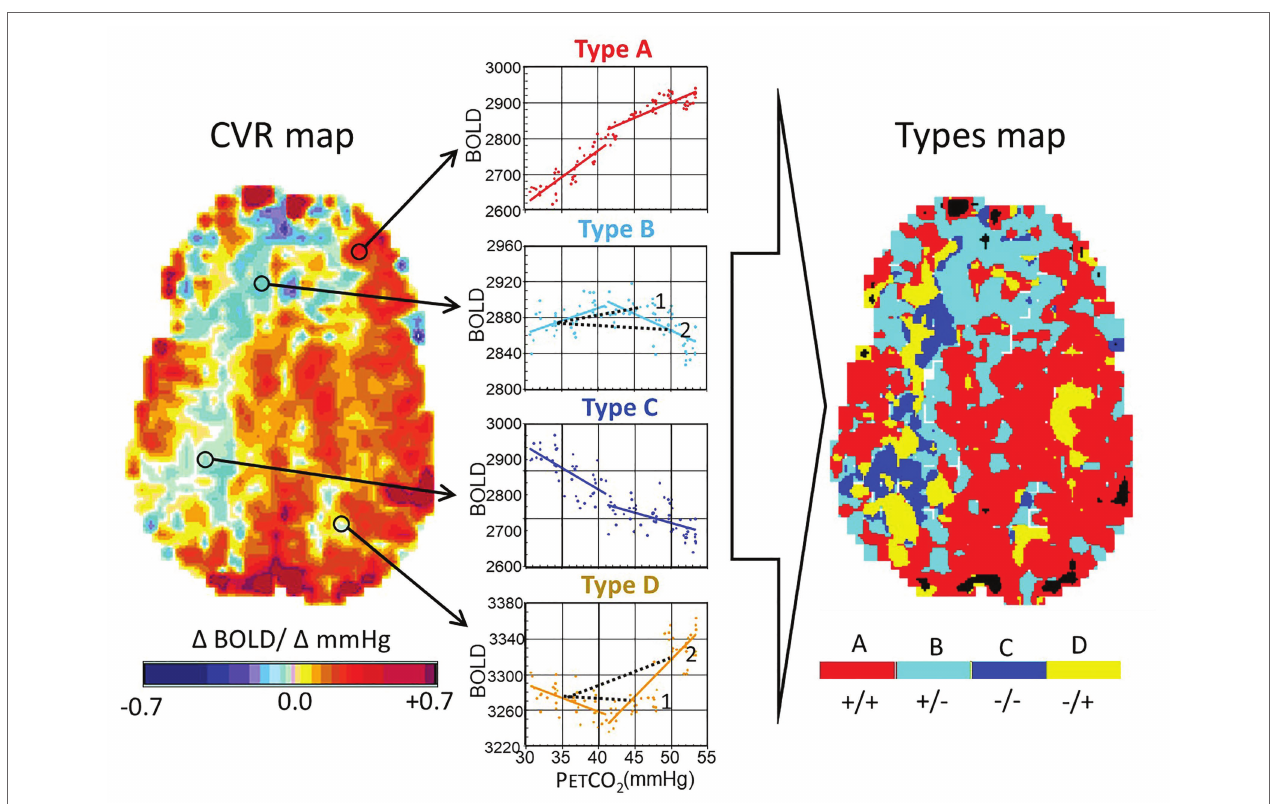
FIGURE 4 | Analysis of ramp hypercapnia data. Stimulus paradigms in an 18-year-old male subject with a history of moyamoya disease affecting the right middle cerebral artery and both anterior cerebral artery territories. The end-tidal PCO 2 (PETCO 2 ) was initiated at baseline PETCO 2 , reduced to 30 mmHg by asking the subject to hyperventilate, and then raised at a constant rate, regardless of minute ventilation or breathing pattern, resulting in a linear rise of PETCO 2 vs. time, to 55 mmHg over 4 min. We examined the blood oxygen-level dependent (BOLD) signal as a function of PCO 2 . The interrogated voxel locations are indicated by the circles on the CVR maps. Types of response: A, positive response with a sigmoidal shape; B, initial positive response which then declines; C, response which progressively declines; and D, response that initially declines but then increases. In healthy people, A Type voxels overwhelmingly predominate, and the map is substantially red. In this patient, voxels are color coded according to the color of the graph corresponding to the Type. Note the projection of CVR as would have been calculated for a 2-point PETCO 2 stimulus of 45 and 50 mmHg for the voxels of Type B and D (see 1 and 2). In the upper figure, a PETCO 2 stimulus of 45 mmHg results in a positive CVR but at a PETCO 2 of 50 mmHg, CVR of the same voxel is negative, indicating “steal.” In the lower figure, PETCO 2 of 45 mmHg results in a negative CVR and at 50 mmHg, it is positive. Modified from Duffin et al.